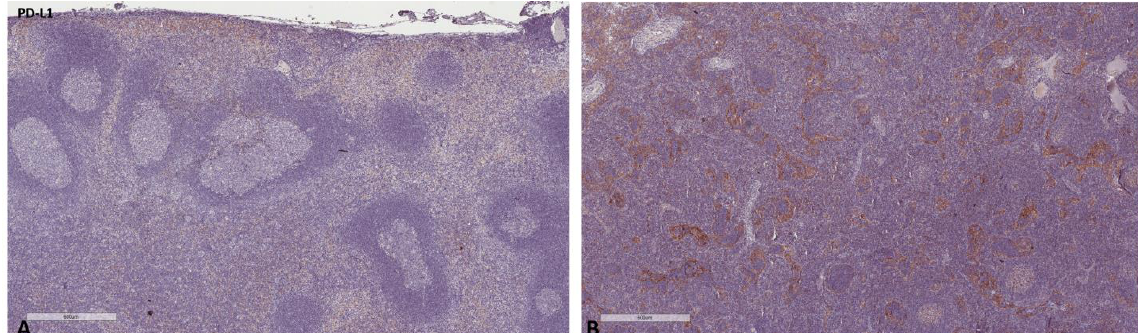
Figure 5. Representative microscopic images of PD-L1 expression (higher magnification) in a nor- mal cancer-draining lymph node ( A ) and a normal non-cancer-draining lymph node ( B ). Figure 6. Representative microscopic images of tenascin-C expression in a normal cancer-draining lymph node ( A ) and a normal non-cancer-draining lymph node ( B ).